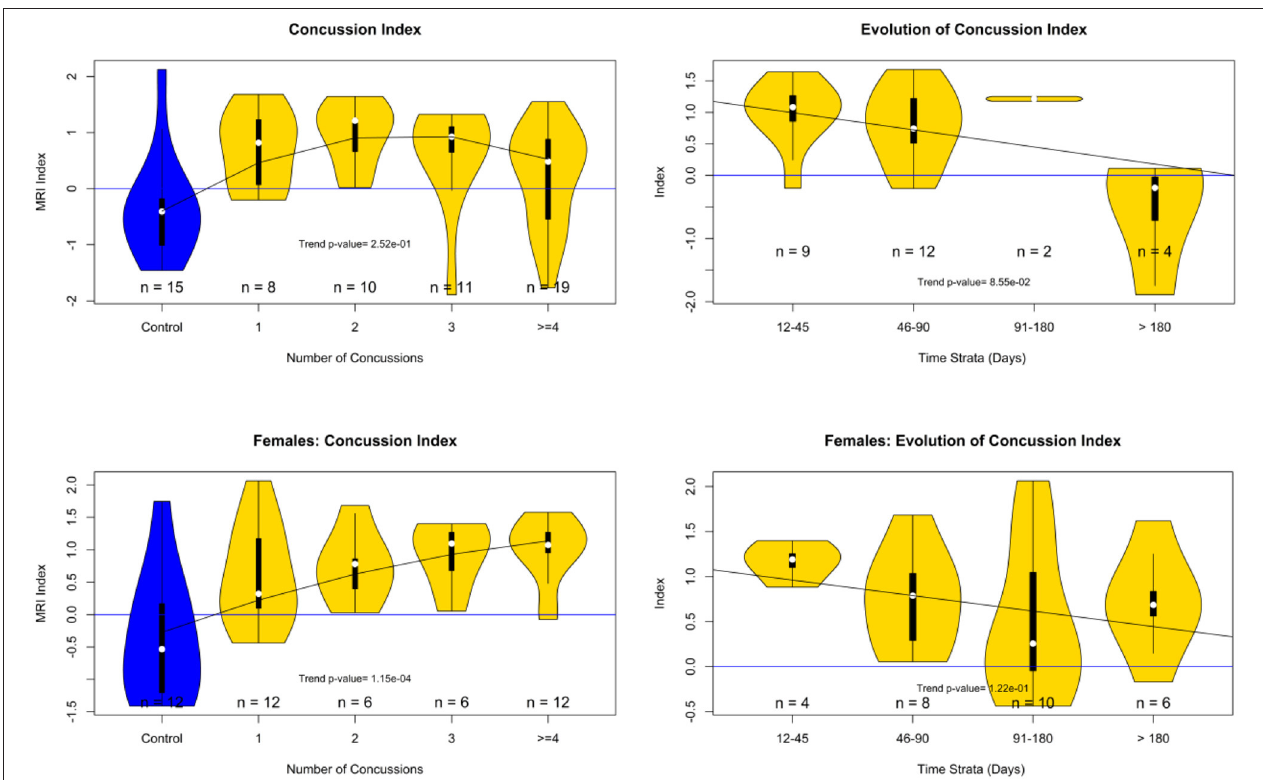
FIGURE 8 | PCS Index analysis by gender. Top row males. Bottom row females. Left index value stratified by the number of concussions. Right index change by time strata (days from